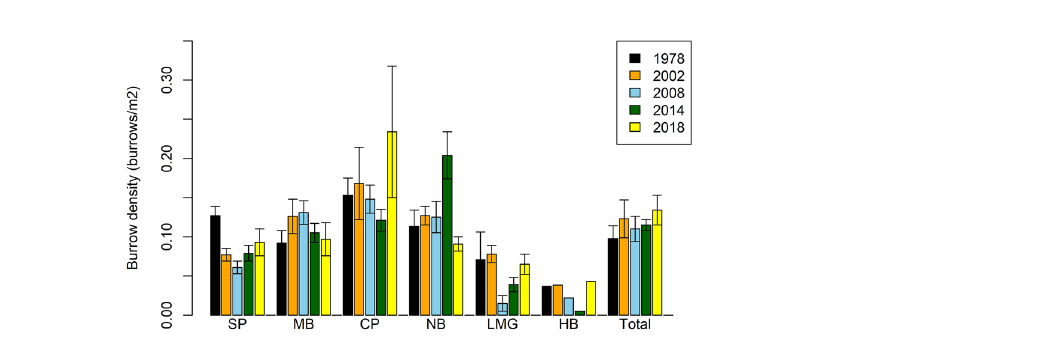
Figure 2. Estimated flesh-footed shearwater burrow density at each colony on Lord Howe Island in five censuses. Error bars = 1 standard deviation. (SP, Stevens Point; MB, Middle Beach; CP, Clear Place; NB, Neds Beach; LMBG, Little Muttonbird Ground; HB, Hunter